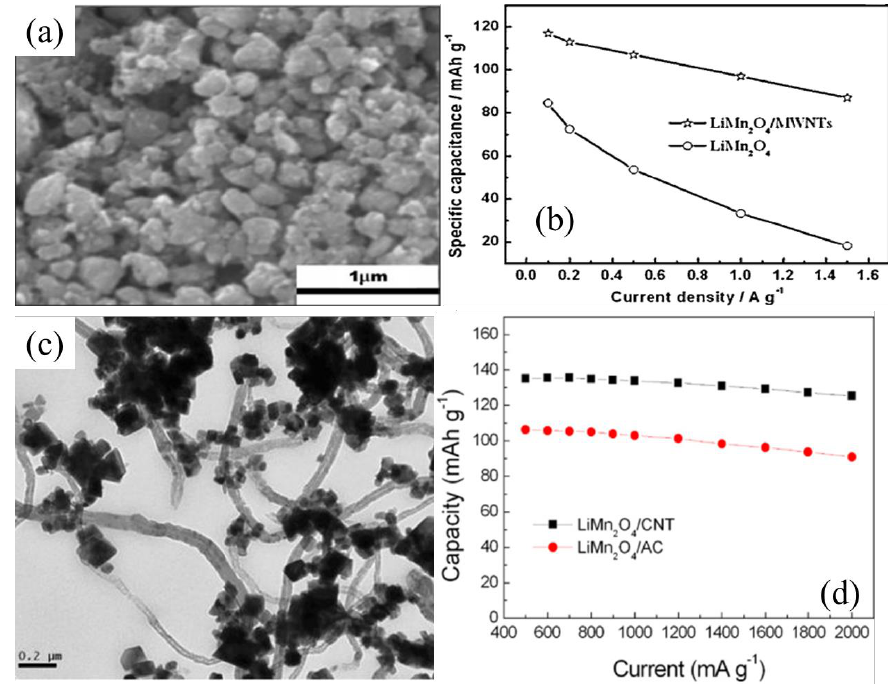
Figure 5. ( a ) SEM image of as-prepared LiMn 2 O 4 /MWNTs composite; ( b ) rate capability of LiMn 2 O 4 and LiMn 2 O 4 /MWNTs in 1 mo·L −1 Li 2 SO 4 solution; ( c ) TEM image of as-synthesized LiMn 2 O 4 /CNT